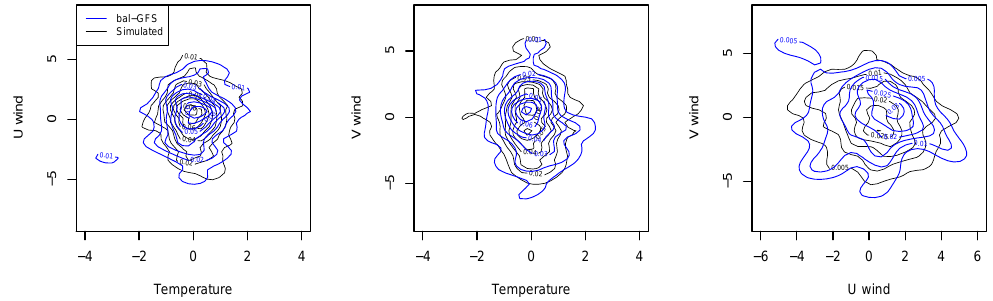
Figure 25. Contourplots of the errors from the difference of balloon data and interpolated values with GFS data and simulated errors generated by t copula and kernel-smoothed empirical CDF.